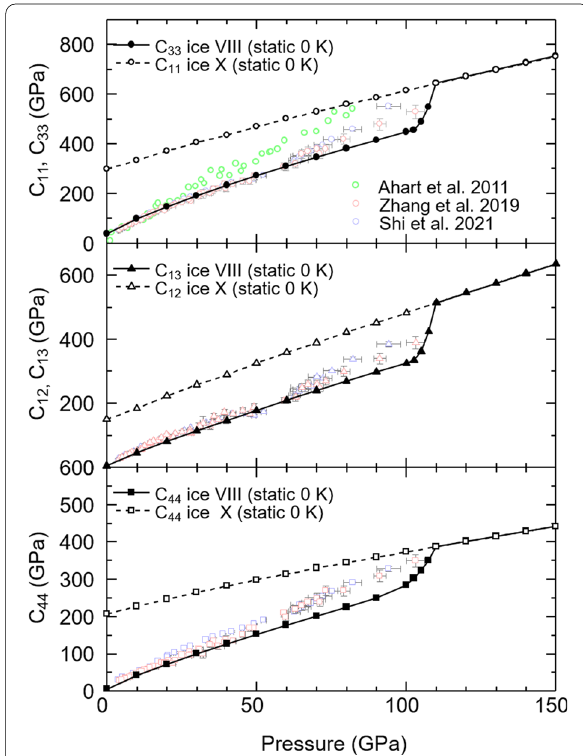
Fig. 6 The calculated and experimental elastic constants of high-pressure ice VIII, VII, and X (Tsuchiya and Tsuchiya 2017; Zhang et al. 2019; Shi et al. 2021; Ahart et al. 2011). The full lines with full symbols indicate the calculated elastic constants of ice VIII containing asymmetric hydrogen bond. Dashed lines indicate the elastic constants of ice X with symmetric hydrogen bond. Note that ice VIII and ice VII have tetragonal and cubic crystal symmetries, respectively, and the index of the elastic constants are different (e.g., C 33 of ice VIII corresponds to C 11 in ice VII and X)